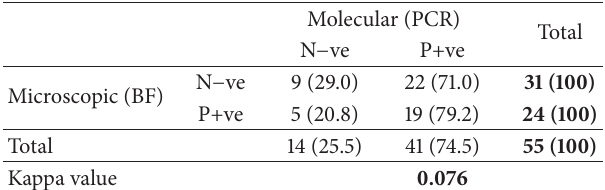
Table 3: The level of agreement between the two techniques using Kappa